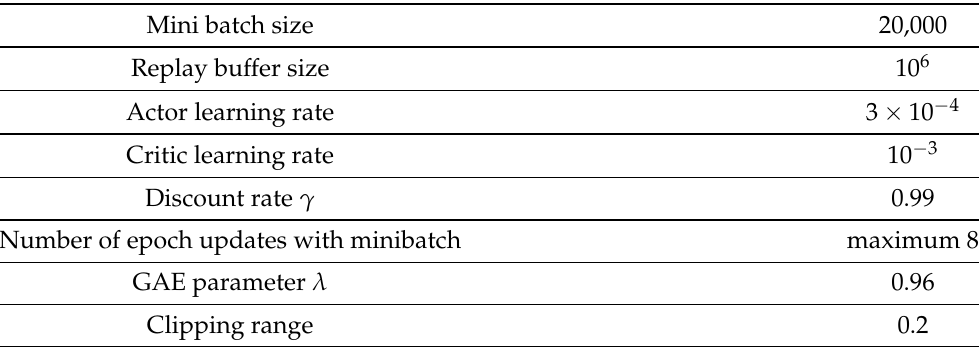
Table A2. Parameters used for the